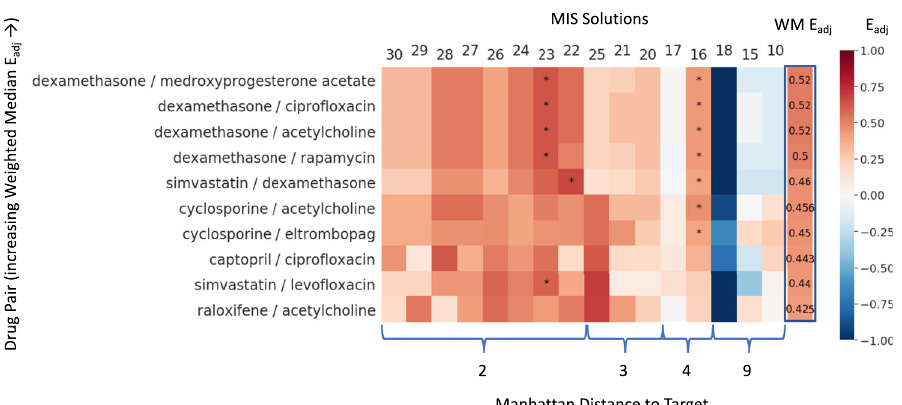
Fig. 4 Ranking drug combinations. Adjusted enrichment E adj values obtained in each of the 16 signi fi cantly actionable MIS interventions (empirical null distribution p( A(s) ) < 0.05) computed for the drug pairs with the top ten highest overall weighted median adjusted enrichment (WM E adj ). Drug pairs are ordered along the vertical axis by increasing weighted median E adj and MIS solutions along the horizontal axis by increasing residual Manhattan distance (bits) separating the treatment outcome from the target healthy resting state. Asterisks indicate an E adj value with an empirical null distribution p( E adj ) < 0.05 signi fi